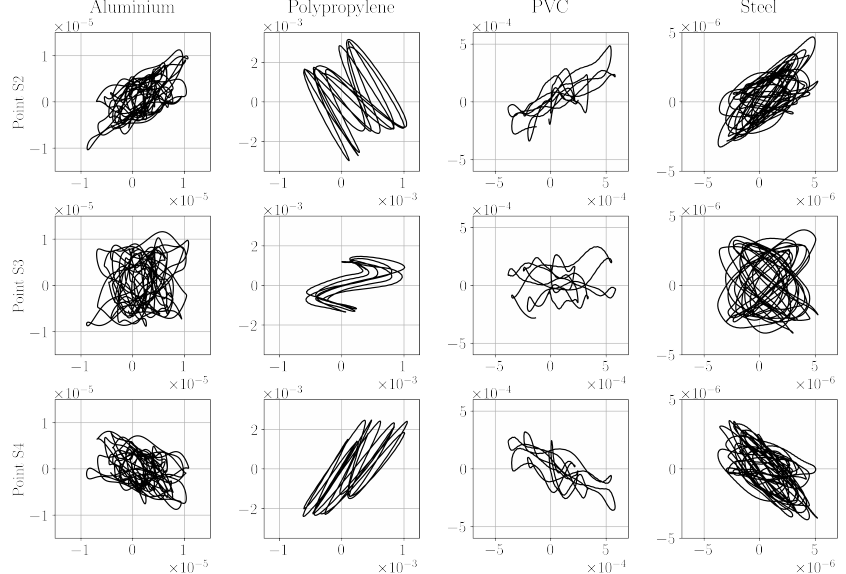
Figure 10. Displacement d y - d x trajectories of points S2, S3 and S4 for each material (in meters).